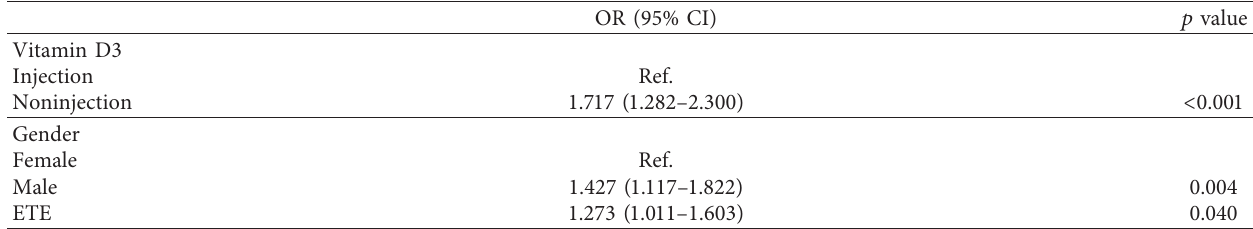
Table 5: Multivariate analysis of clinical parameters which influence transient hypocalcemia.